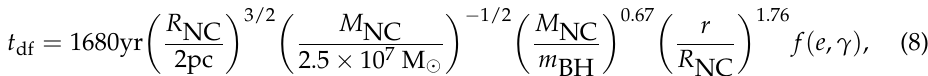
Figure 3. Dynamical friction timescale as a function of the cluster mass assuming that the cluster orbits at 50 pc (green) or 100 pc (red) in a galaxy with total mass M g = 10 11 M R g = 1 kpc, and the slope of the density profile γ = 0.5. For comparison, we show also the cluster mass segregation time (grey). The shaded areas embrace the boundaries assuming COs with masses m CO = 5 50 M − (cid:12)